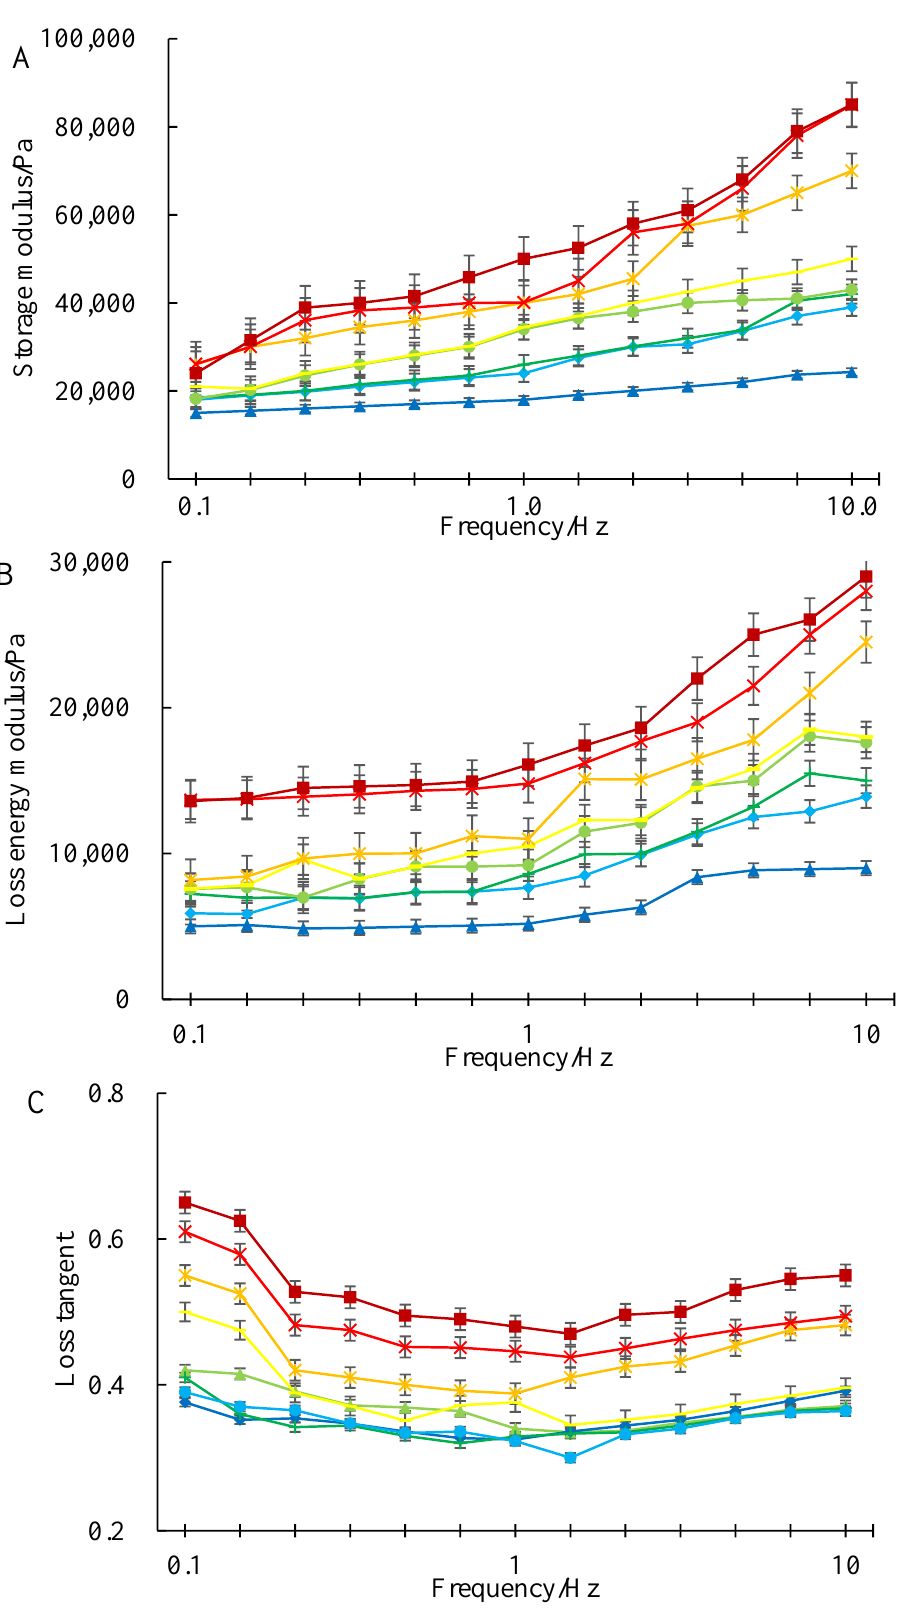
Figure 1. The effect of the addition of honeysuckle powder on the dynamic rheological properties of the dough. Note: ( A ) is the storage modulus, ( B ) is the loss energy modulus, and ( C ) is the loss tangent. ▲ , (cid:7) , ♦ , +, ● , -, *, ✖ , and ■ represent 0, 1%, 2%, 3%, 4%, 5%, 6%, and 7% honeysuckle powder, respectively.